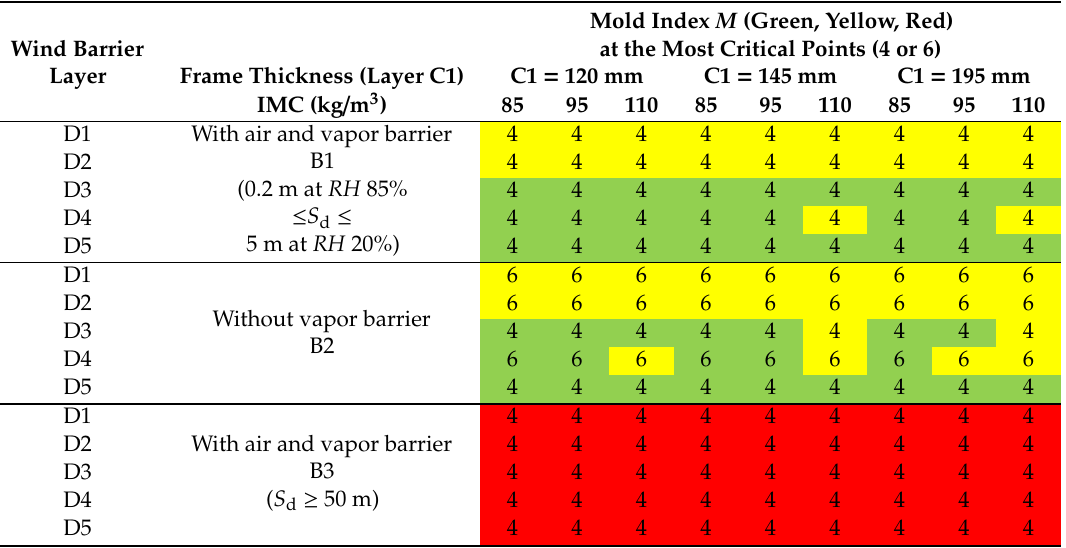
Table 5. Results of calculation of mold index M of wall constructions with MW. IMC of existing concrete wall w = 85 kg / m 3 ( u = 3.7%), w = 95 kg / m 3 ( u = 4.1%), w = 110 kg / m 3 ( u = 4.7%). See Table 1 for description of layers D1–D5.